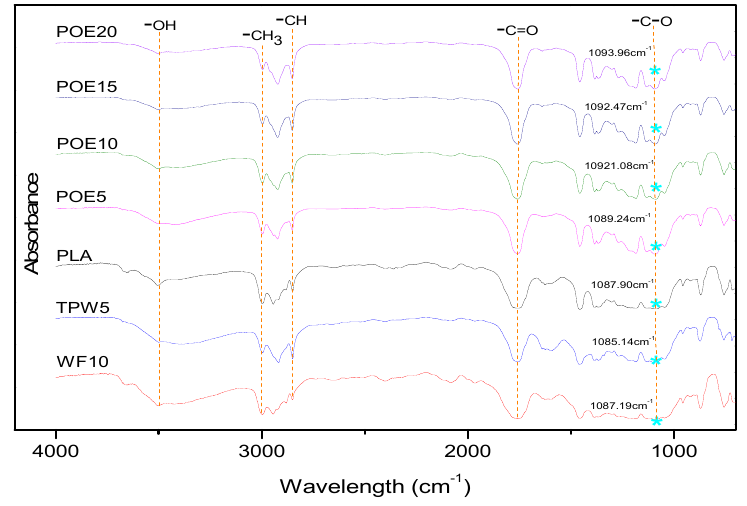
Figure 2. Fourier transform infrared spectra (FTIR) of 3D printing materials.